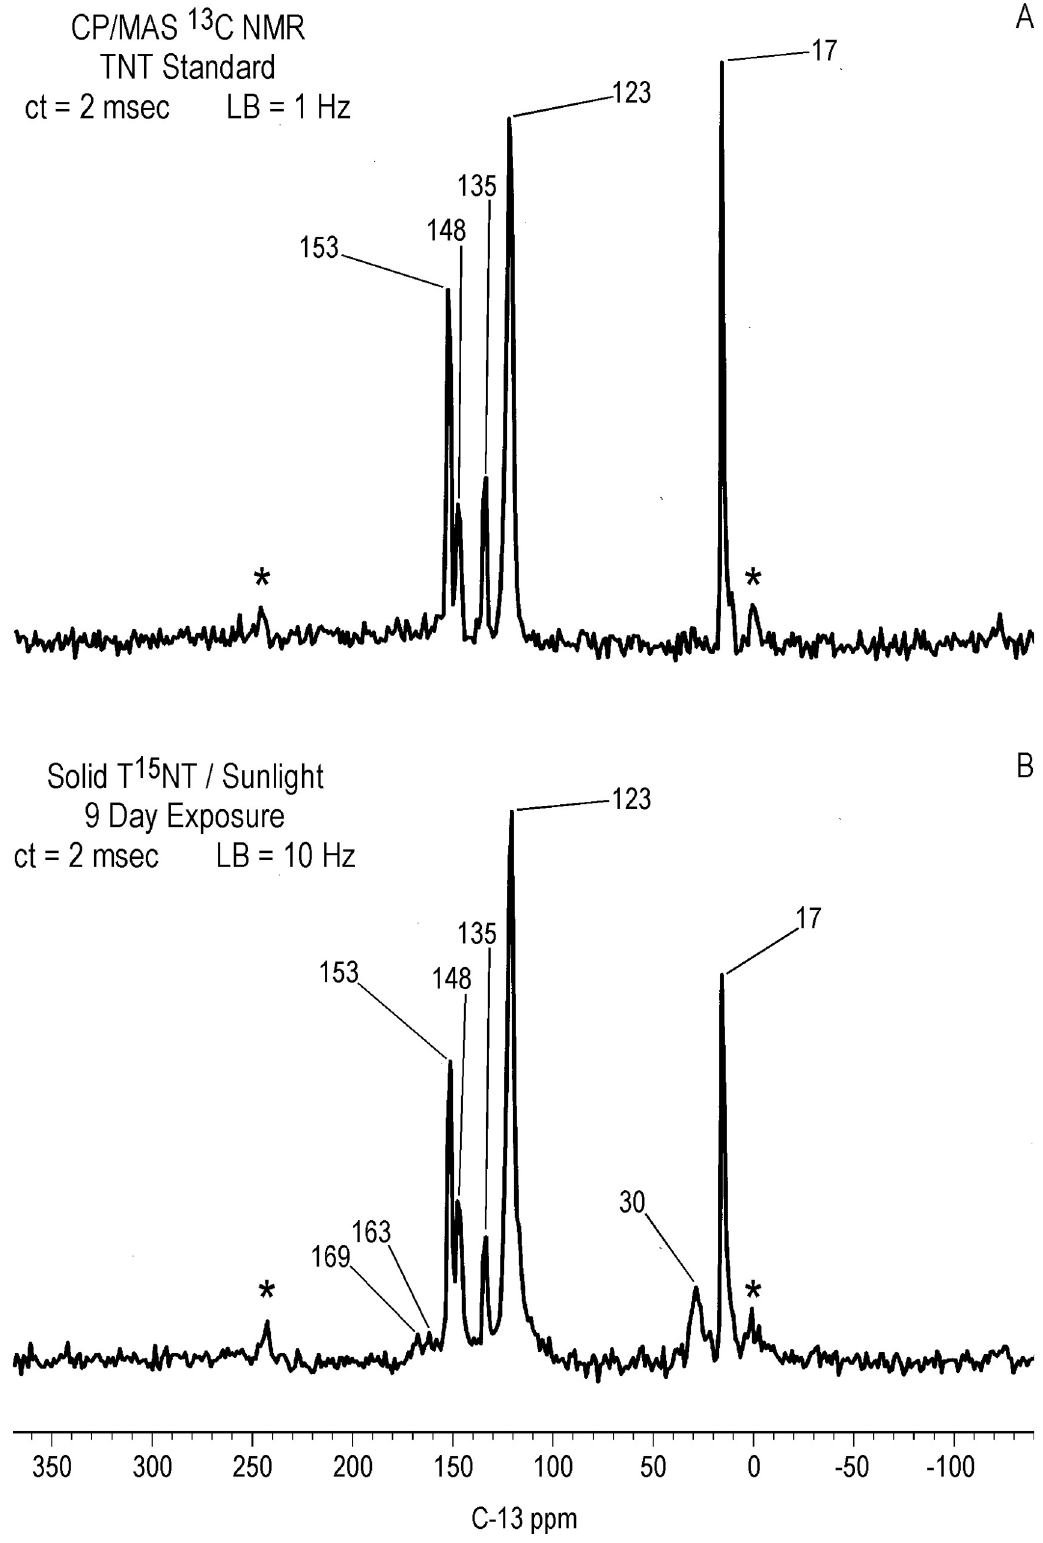
Fig 20. Solid state CP/MAS C-13 NMR spectra of T 15 NT. A. Standard. B. Solid T 15 NT subjected to sunlight irradiation. Spinning speed = 6 KHz. ct = contact time. LB = line broadening. Asterisk = spinning side band. https://doi.org/10.1371/journal.pone.0224112.g020 PLOS ONE | https://doi.org/10.1371/journal.pone.0224112 October 22,